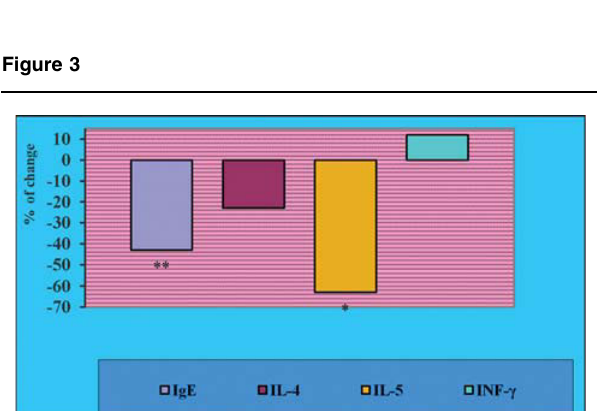
Percentage of change of IgE, IL-4, IL-5 , and IFN- γ values after DLIT. DLIT, diode laser inferior turbinoplasty; IFN, interferon; IgE, immu- noglobulin; IL, interleukin; TLC, total leukocytic